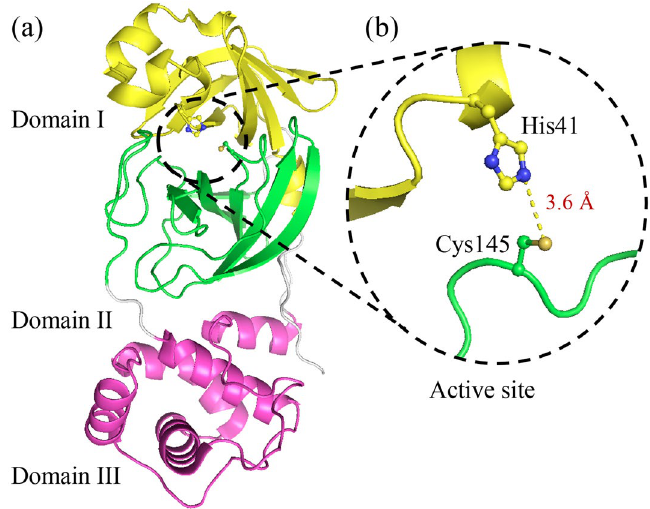
Figure 1. The crystal structure of 3CLpro. ( a ) Cartoon representation of the structural domains of 3CLpro of SARS-CoV-2 (PDB code 6Y2E). Domain I (residues 10–96) is shown in yellow, domain II (residues 102–180) in green, and domain III (residues 200–303) in pink. The active site is located at the interface between domains I and II. ( b ) The active site of 3CLpro showing the catalytic residue Cys145, which is part of domain II, is 3.6 Å from His41 of the catalytic dyad, which is part of domain I. The figure was prepared using PyMol (Schrodinger